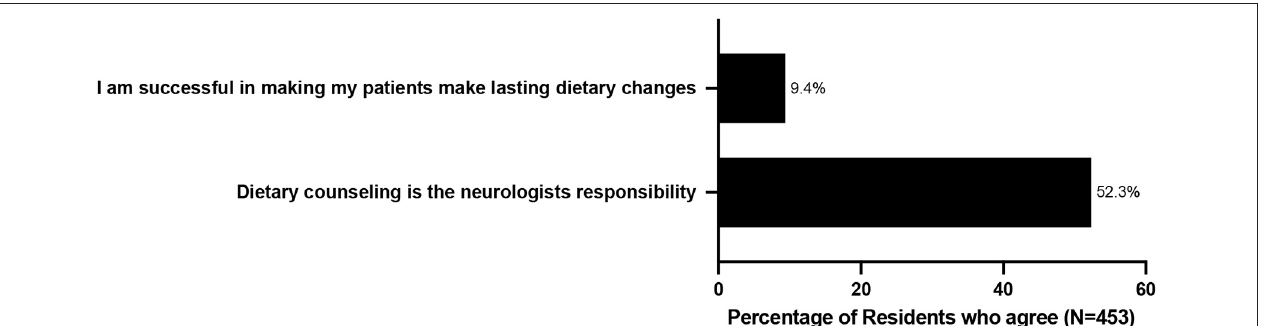
Frontiers in Neurology |